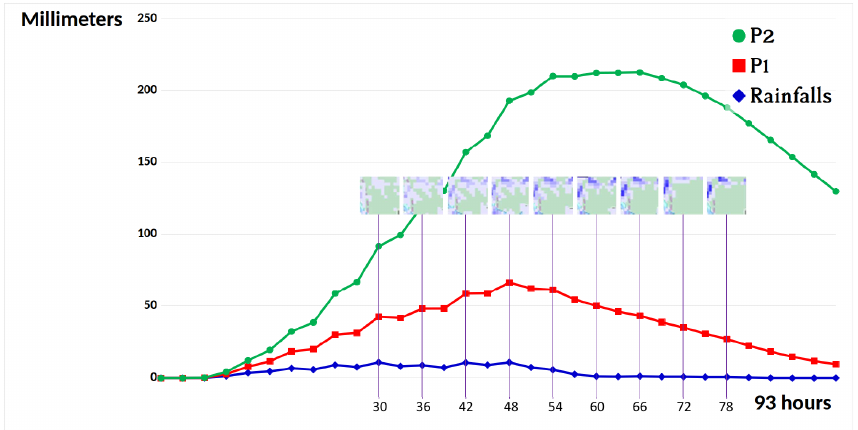
Figure 6. Chart of rainfalls and water levels at two positions in the Soummam river zone during a tropical storm from 13 to 16 November 2017. The blue line shows rainfalls during four days recorded every 3 h [30]. The two lines in red, green color present water level at P1, P2, respectively (also see Table 1). The distance between P1 and P2 is 300 m. Due to the significant slope of the ground surface in this complex terrain, a large amount of water was accumulated at lower points, causing a flash flood, and possibly a catastrophic